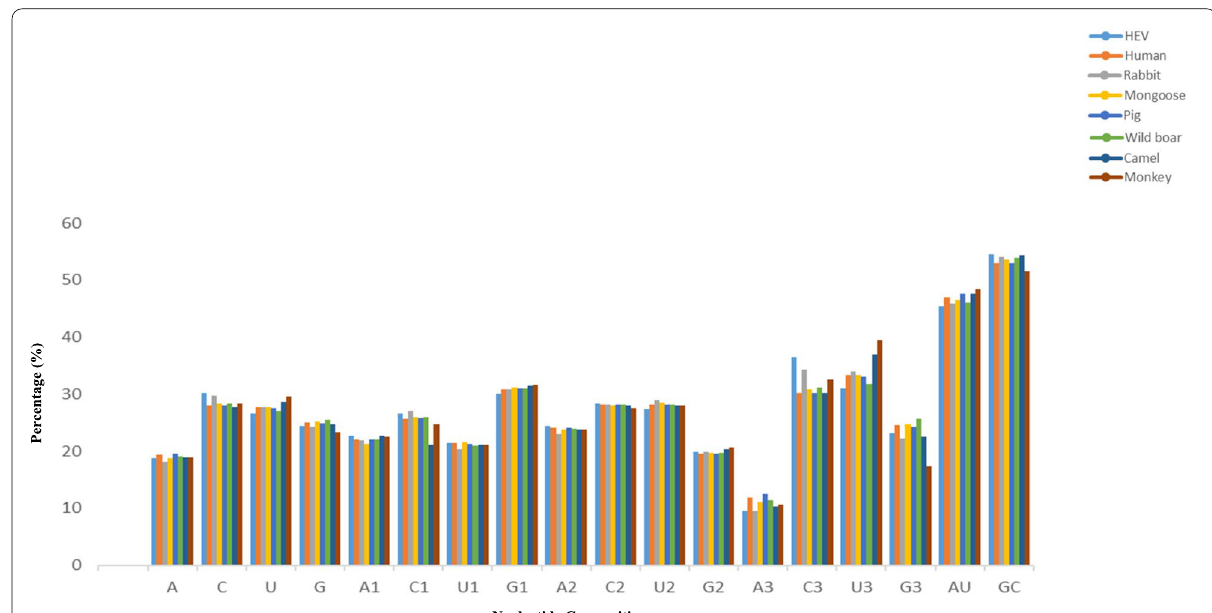
Fig. 1 Comparative analysis of nucleotide composition patterns between HEV and its hosts (human, rabbit, mongoose, pig, wild boar, camel, and